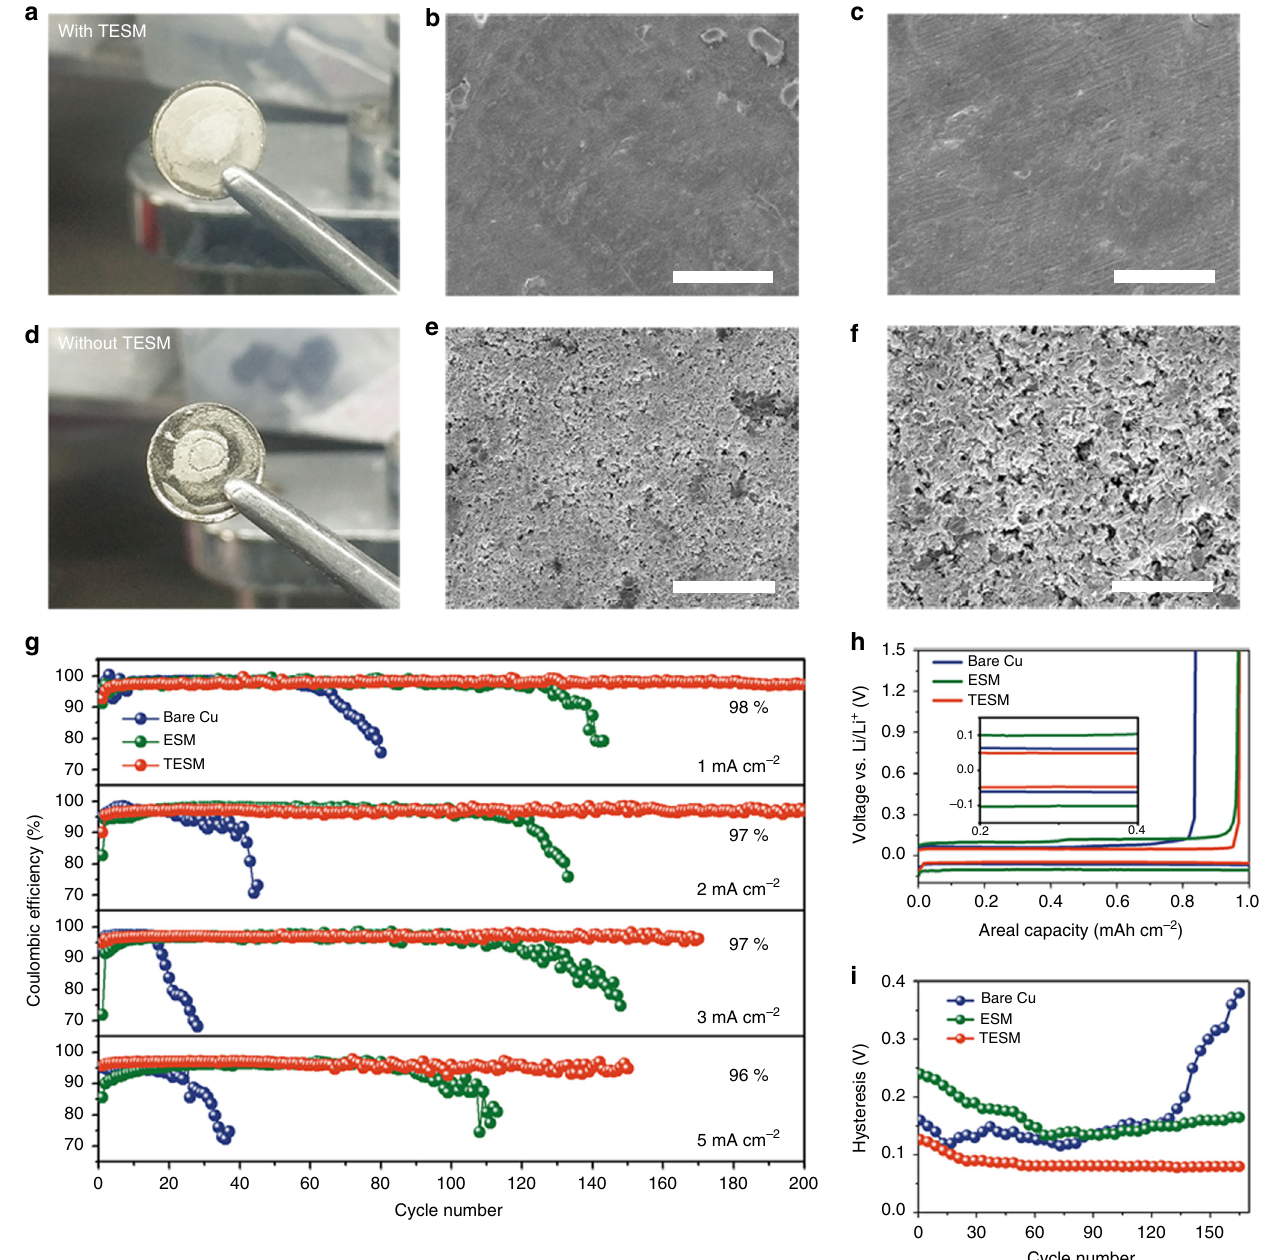
Fig. 4 Morphology and cycling stability of a Li anode assisted by TESM in ether-based electrolytes. a , d Optical photographs of ( a ) Li foil protected by TESM and ( d ) bare Li foil after 20 cycles at 2 mA cm − 2 for 1 mAh cm − 2 . b , c , e , f SEM images and corresponding enlarged areas of ( b , c ) TESM-protected Li and ( e , f ) unprotected Li, respectively. Scale bars, ( b , e ) 50 μ m and ( c , f ) 20 μ m. g Comparison of CEs with bare Cu, ESM-modi fi ed Cu, and TESM- modi fi ed Cu at various current densities. The fi xed cycling capacity in each cycle is 1 mAh cm − 2 . h The voltage pro fi les for the electrodes at 3 mA cm − 2 . i The corresponding voltage hysteresis of electrodes with a current density of 3 mA cm − 2